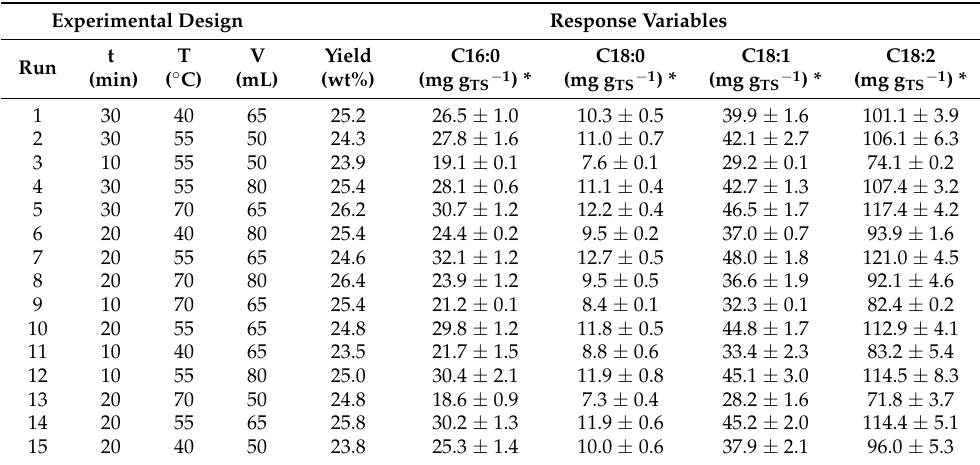
Table 1. BBD matrix and response values obtained for TSO extracts by